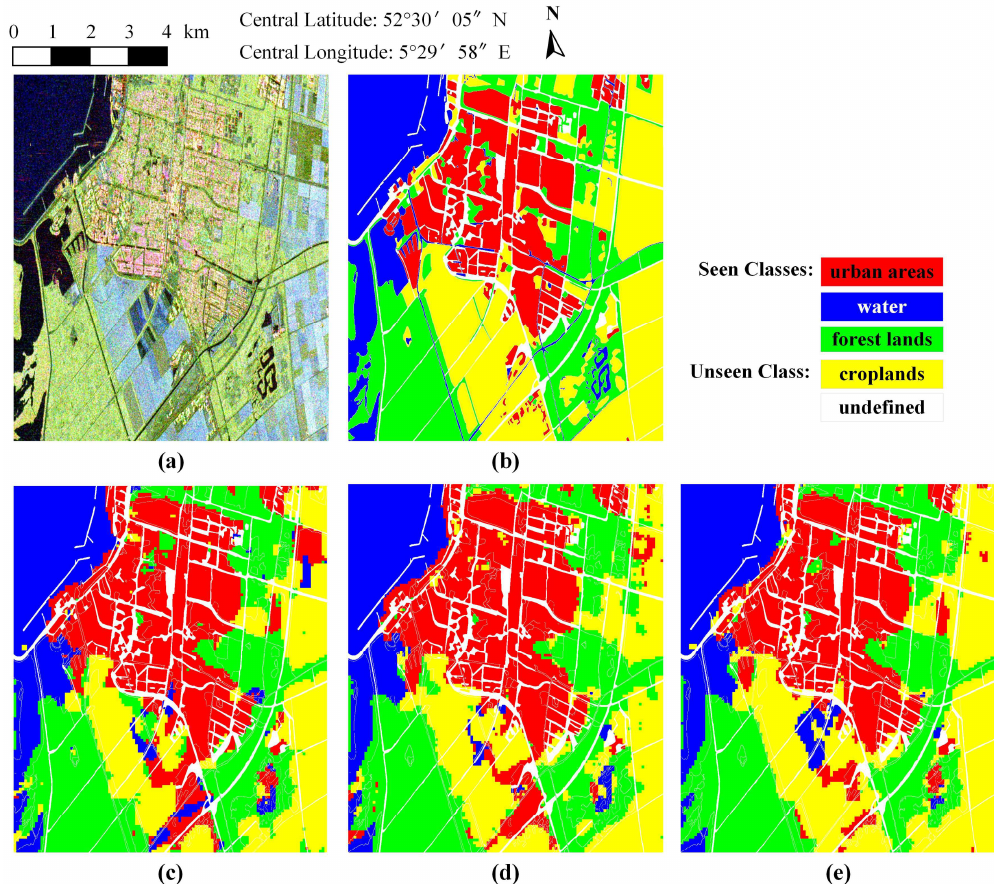
Figure 4. The GZSL classification results of the Flevoland data (the unseen class is croplands). ( a ) Pauli RGB image of the Flevoland data; ( b ) the ground truth map of the Flevoland data; ( c ) the results of the Word2Vec attributes applied; ( d ) the results with SUN attributes applied; and ( e ) the results with the selected SUN attributes applied.